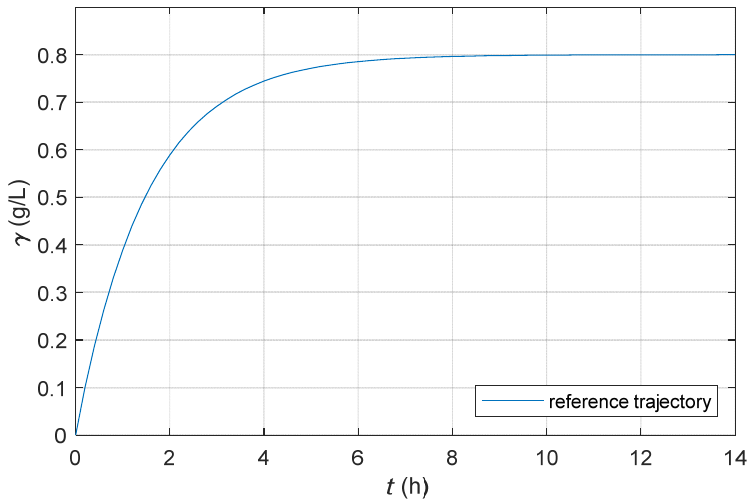
Figure 6. Time course of dissolved CO 2 concentration γ of the chosen reference model for the laboratory batch bioreactor.